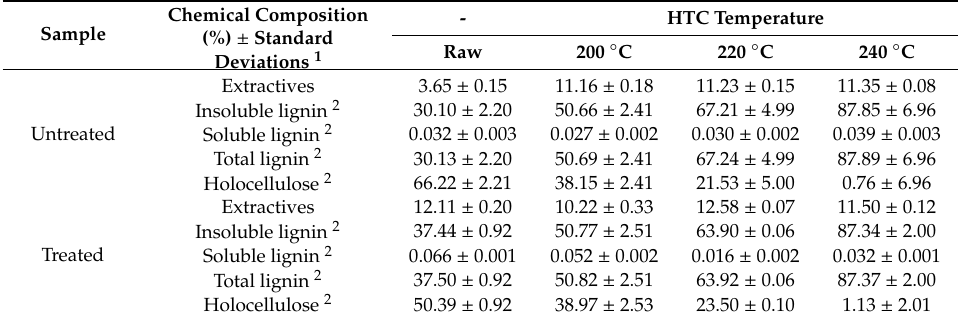
Table 3. Lignocellulosic composition of the samples in (%) before and after hydrothermal carbonization (HTC)